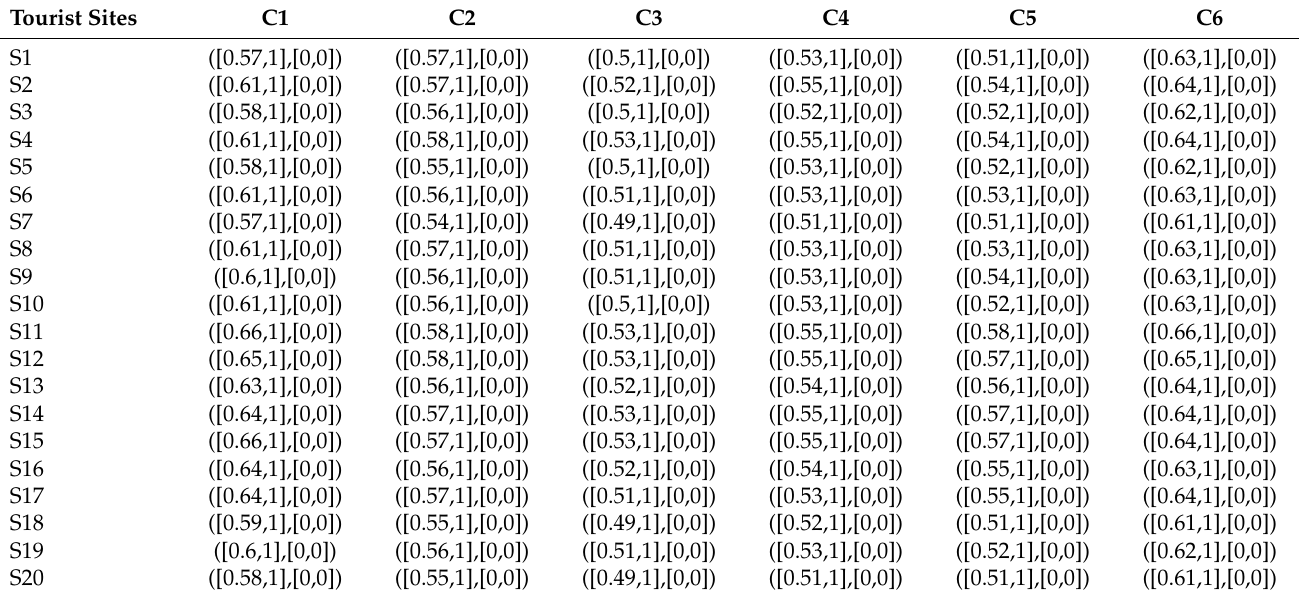
Table 6. The weighted IVIF dataset for the evaluation of tourist